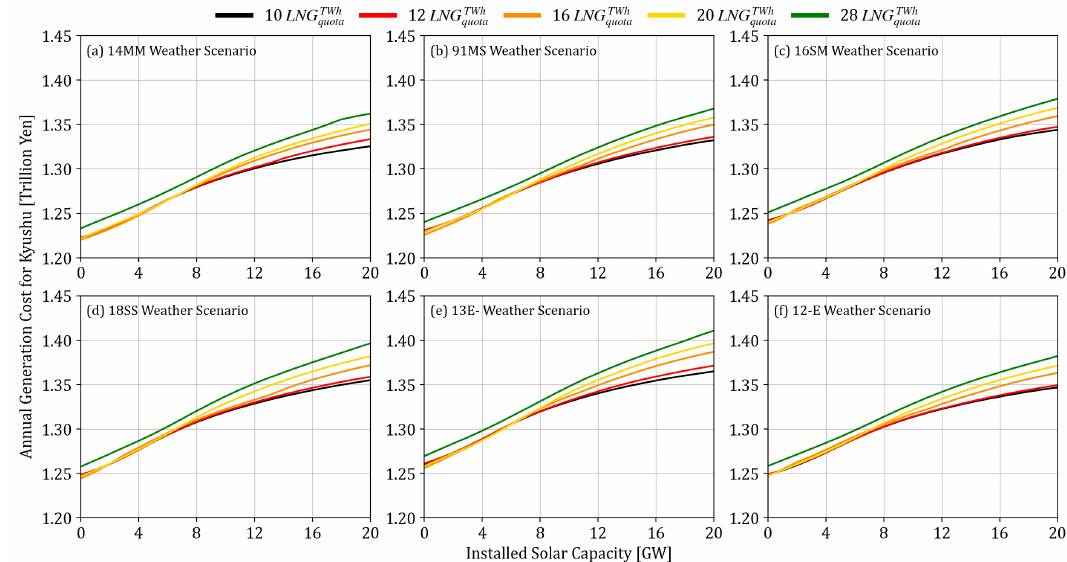
Figure 17. Annual generation costs for various scenarios in Kyushu.